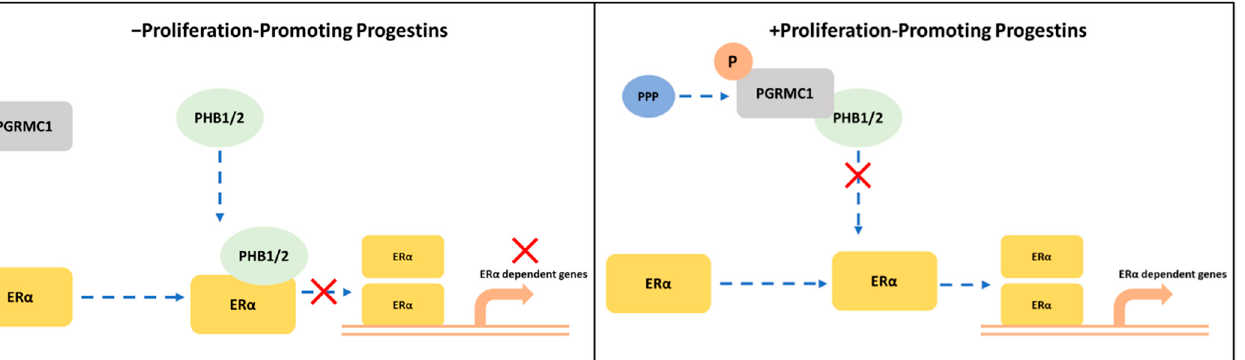
Figure 6. Potential crosstalk between PGRMC1 and PHB1/2 in ER α -signaling cascades. S181-phosphorylation on PGRMC1 mediates interaction with PHB1/2 upon treatment with proliferation-promoting progestins (PPPs). In absence of PPPs: PHB1/2 act as ER α co-regulators to inhibit the transcription of ER α -dependent genes. In presence of PPPs: S181-phosphorylated PGRMC1 interacts with PHB1/2, possibly inhibiting their function as transcription factor regulators and enabling the transcription of ER α -dependent genes.